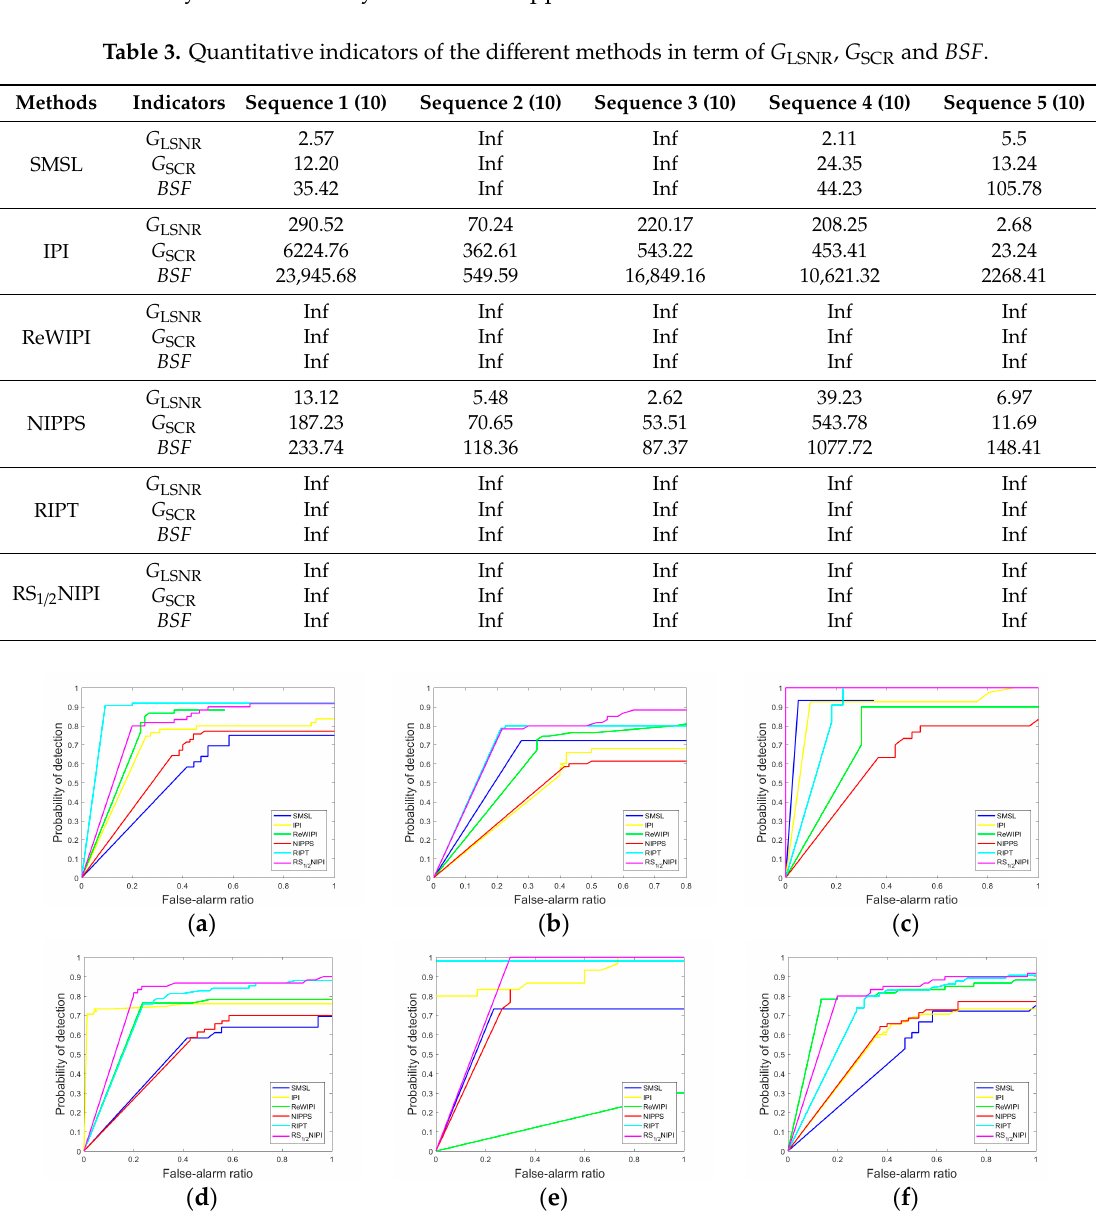
Table 4. The detailed parameter settings for the saliency and filtering based methods.